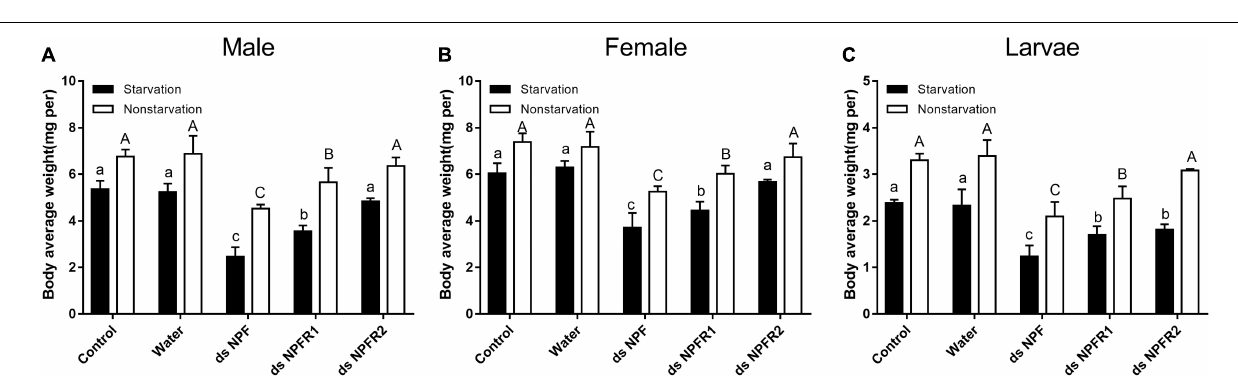
FIGURE 6 | Effect of dsNPF, dsNPFR1, and dsNPFR2 on body average weight of D. armandi . Samples were collected and assayed at 72 h after injection. In the RNAi experiments, body average weight of male (A) , female (B) , and larvae (C) in the state of starvation and non-starvation was analyzed. Different letters indicate significant differences at the 0.05 level (uppercase for non-starvation, lowercase for starvation). All values are mean ± SE , n =